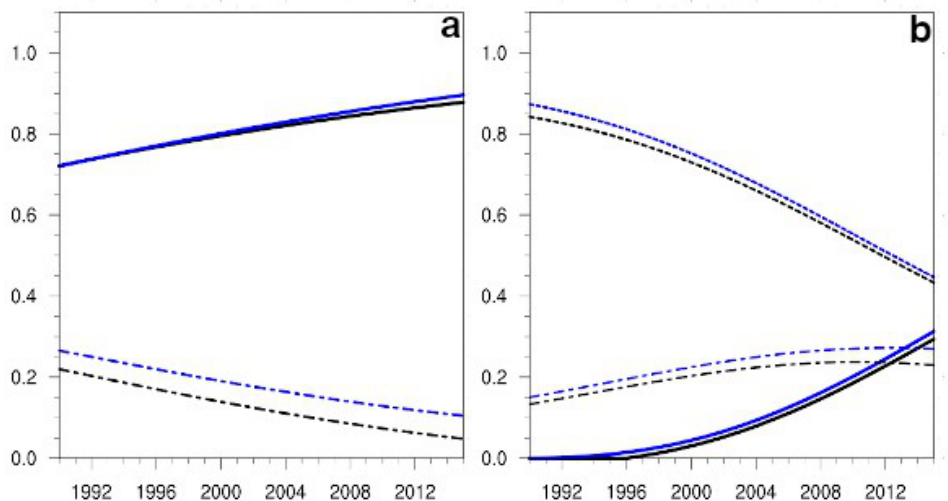
Figure 6. ( a ) Projection in time of the Sobol sensitivity indices, S i and S T and the National flights (S), in the case study selected ( β values in the interval (0.1, 0.5). Line styles and colour codes as in Figure 4a. ( b ) The evolution in time of the Sobol sensitivity indices for the emissions variable for the same flight type and case study, with colour codes and line styles as in Figure